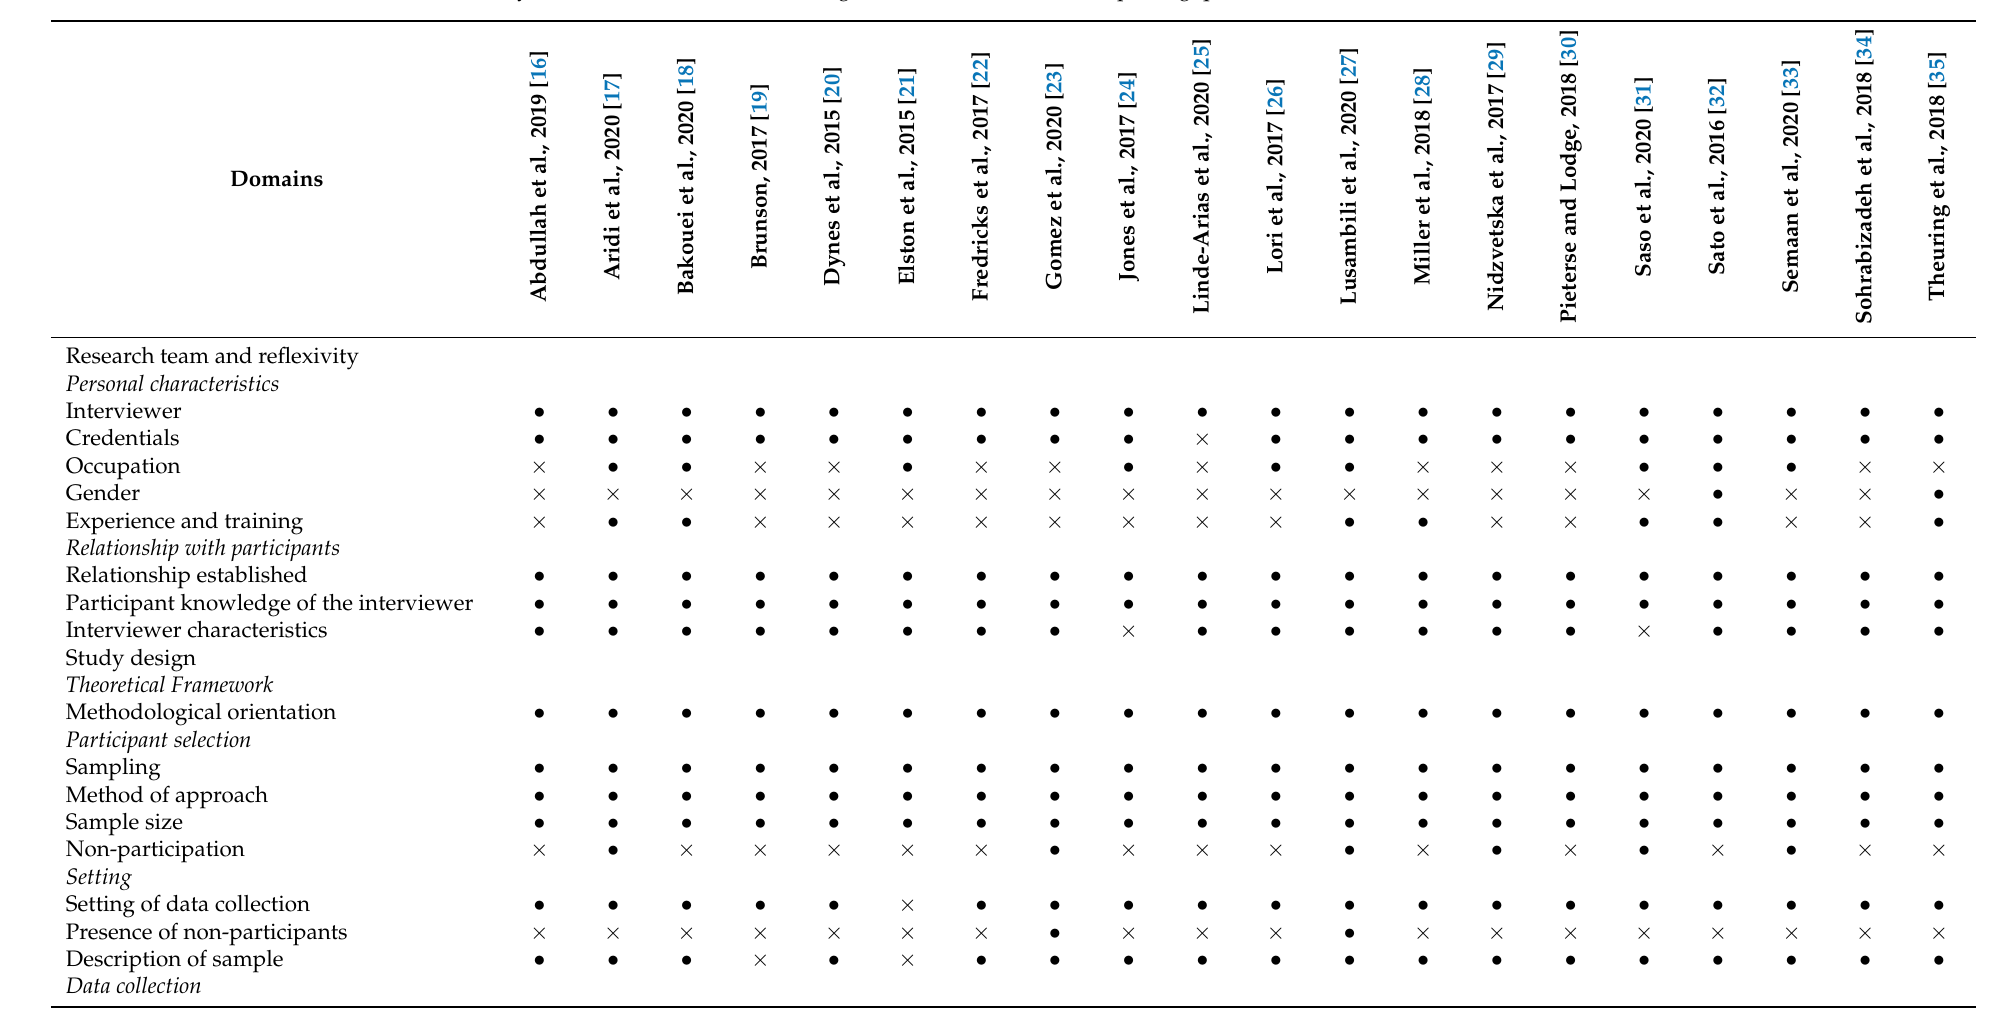
Table 4. Quality assessment of the studies, using consolidated criteria for reporting qualitative research (COREQ) assessment tool.